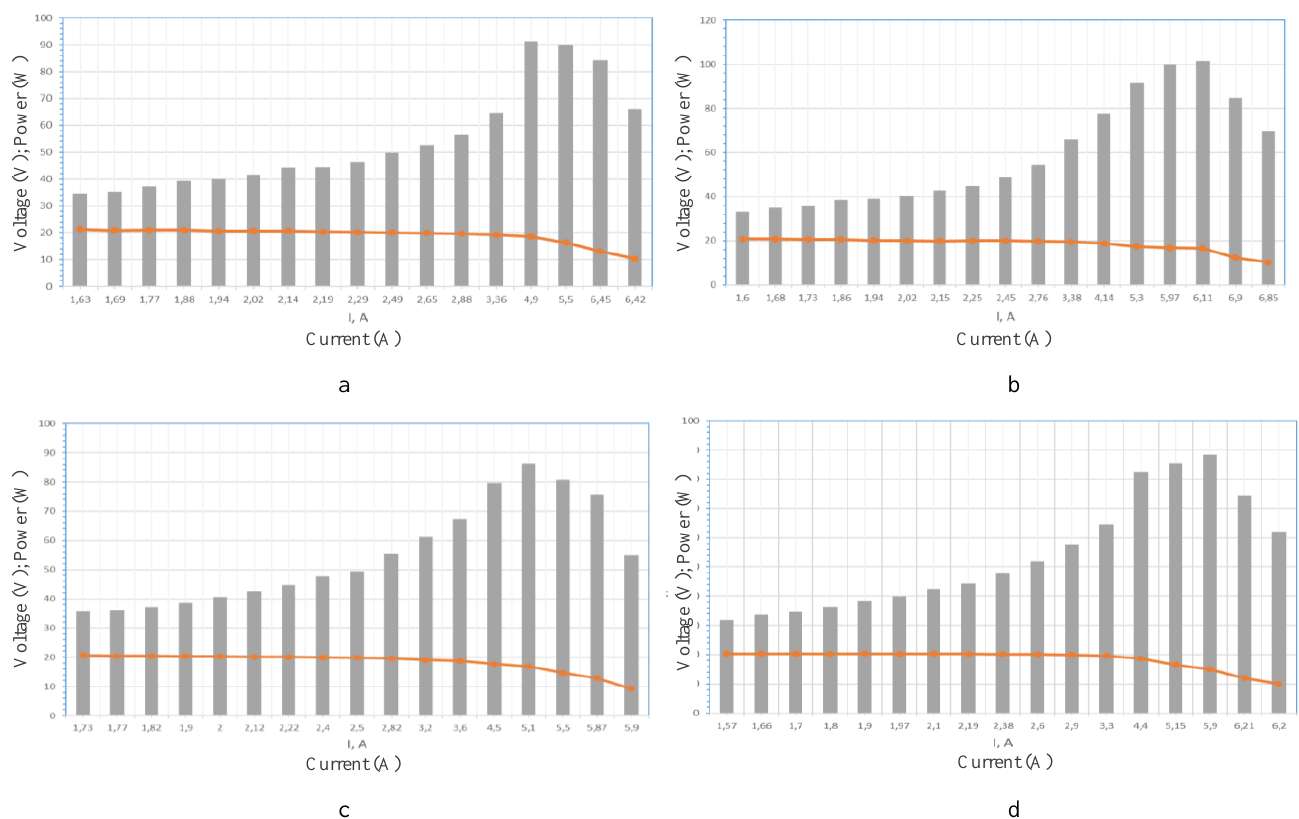
Fig. 4. Volt-ampere and load characteristics of the PV panel: a, b – polycrystal; c, d –